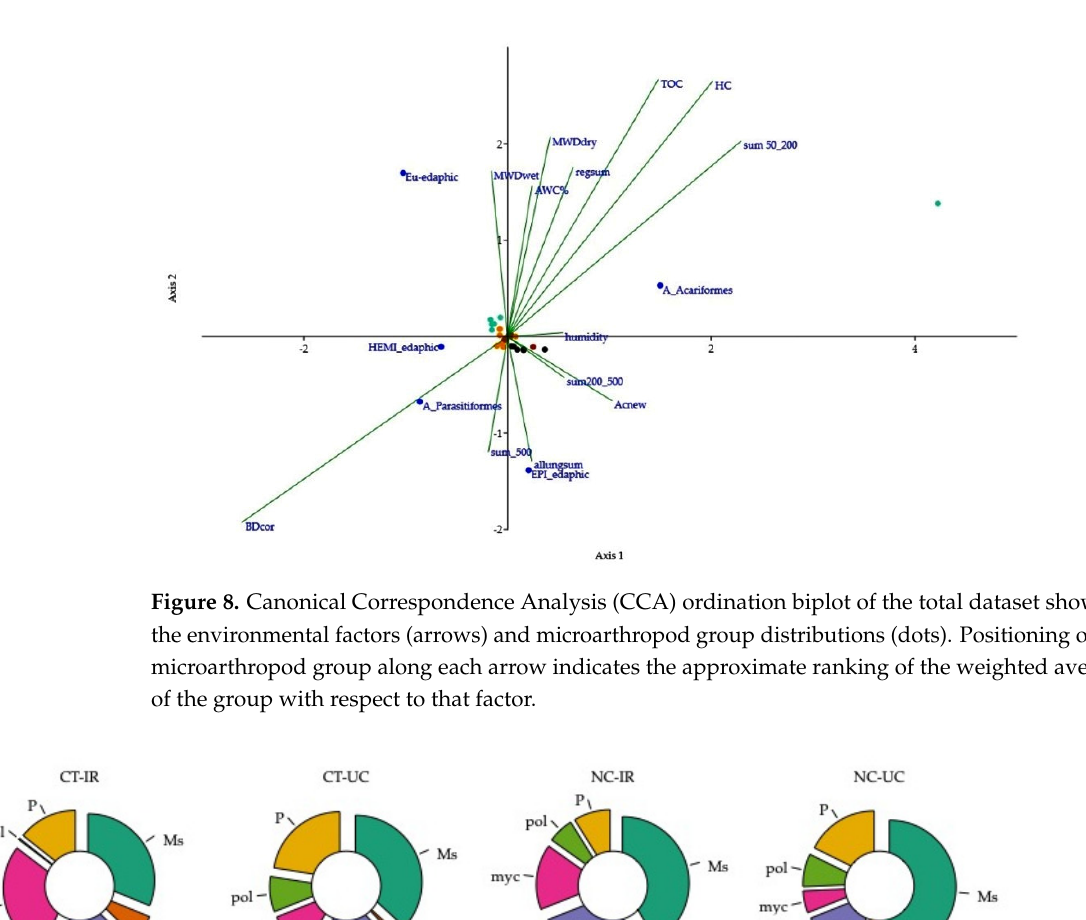
Figure 9. Feeding functional biodiversity of the soil arthropods (%) in each management: macrosaprophagous in green (Ms: Acari, Isopoda, Coleoptera adult and larvae, Diplopoda and Collembola); herbivorous/fluid feeders in orange (H: Acari, Diptera larvae, Hemiptera, Lepidoptera larvae and Thysanoptera); microsaprophagous in violet (mcs: Acari, Diplura, Diptera larvae, Pauropoda and Collembola); mycophagous in purple (myc: Acari, Coleoptera, Collembola and Protura); polyphagous in light green (pol: Acari, Formicidae, Psocoptera and Symphyla) and predators/parasitoids in dark yellow (P: Araneida, Coleoptera, Chilopoda, Coleoptera larvae, Diplura, Hymenoptera, Acari, Pseudoscorpionida and Diptera larvae).